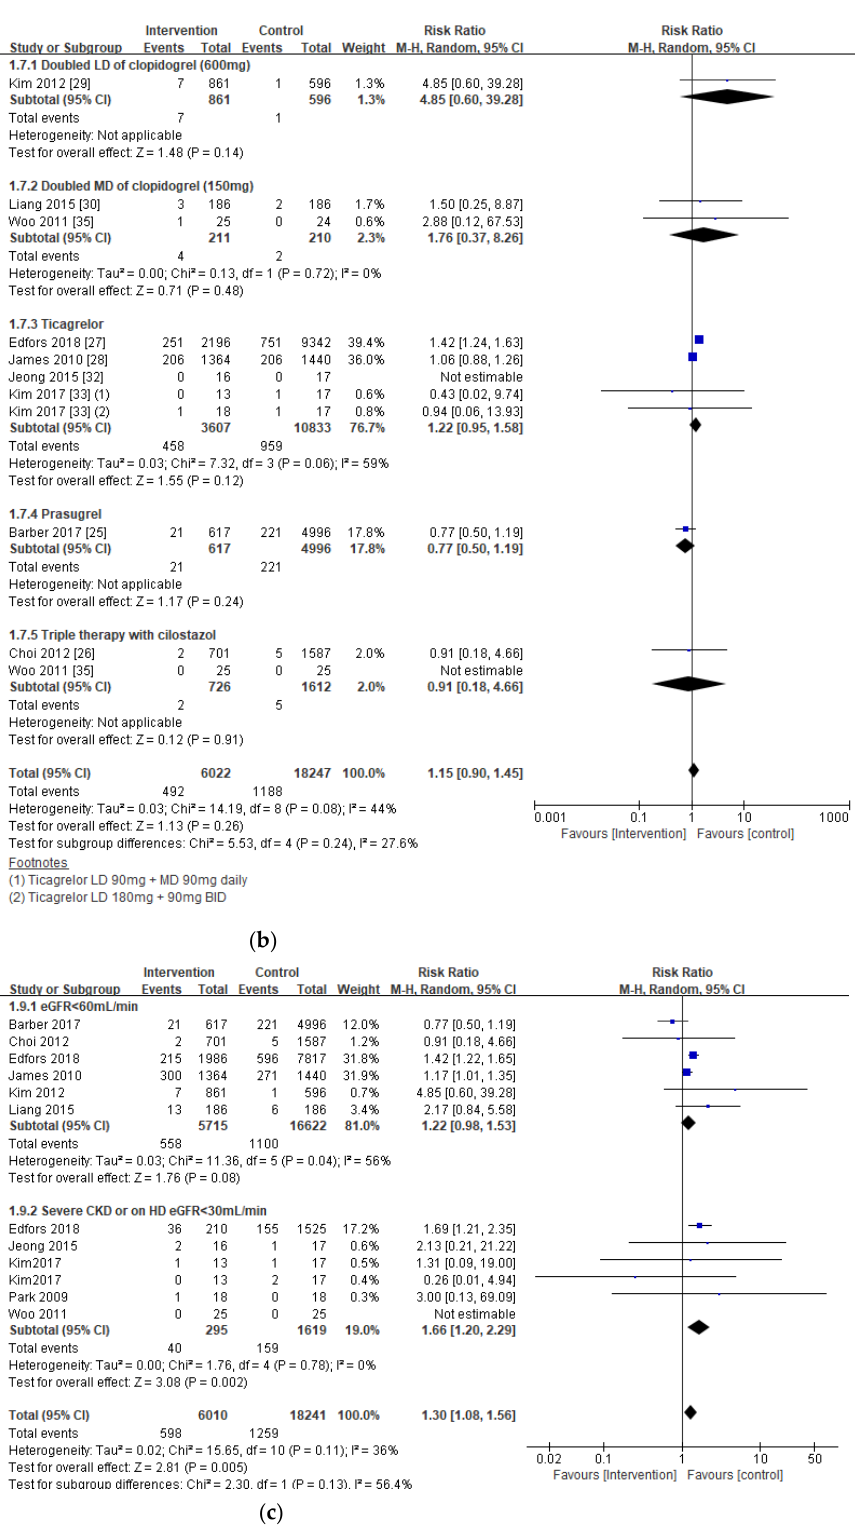
Figure 4. Forest plots of bleeding risks associated with antiplatelet therapy in all CKD patients, including those on hemodialysis: ( a ) major bleeding; ( b ) minor bleeding; and ( c ) subgroup analysis of major and minor bleeding between estimated glomerular filtration rate (eGFR) < 60 mL/min and eGFR < 30 mL/min or hemodialysis (HD). Blue indicates the risk ratio evaluated from each study and black indicates the overall risk ratio of the antiplatelet